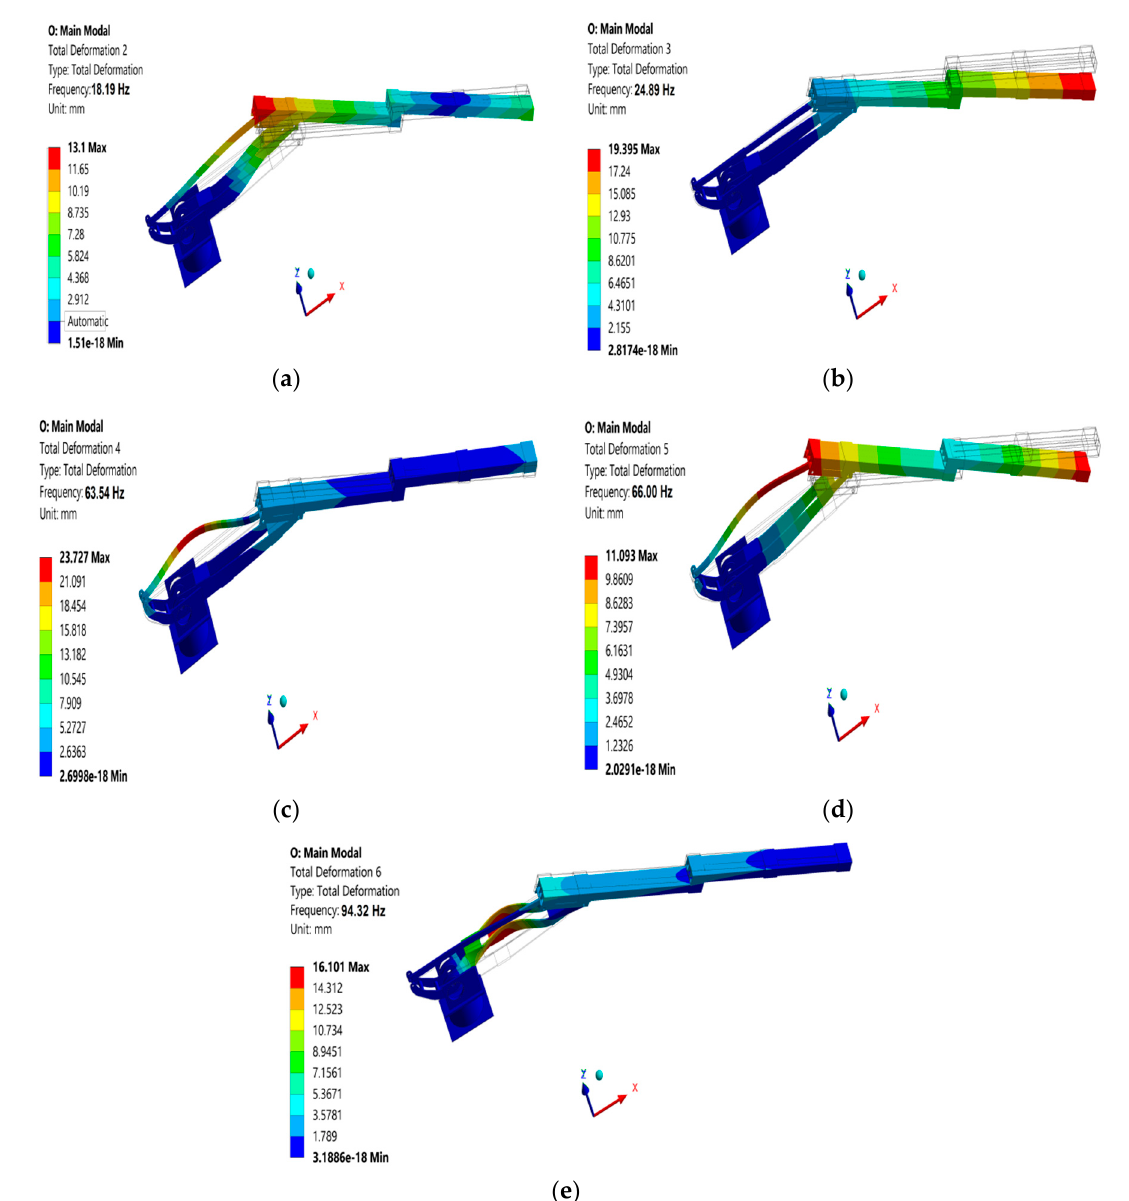
Figure A2. Natural frequencies and corresponding mode shapes for the CFRP 5 ‐ DOF manipulator in Configuration 2: ( a ) second frequency, ( b ) third frequency, ( c ) fourth frequency, ( d ) fifth fre ‐ quency, and ( e ) sixth frequency.